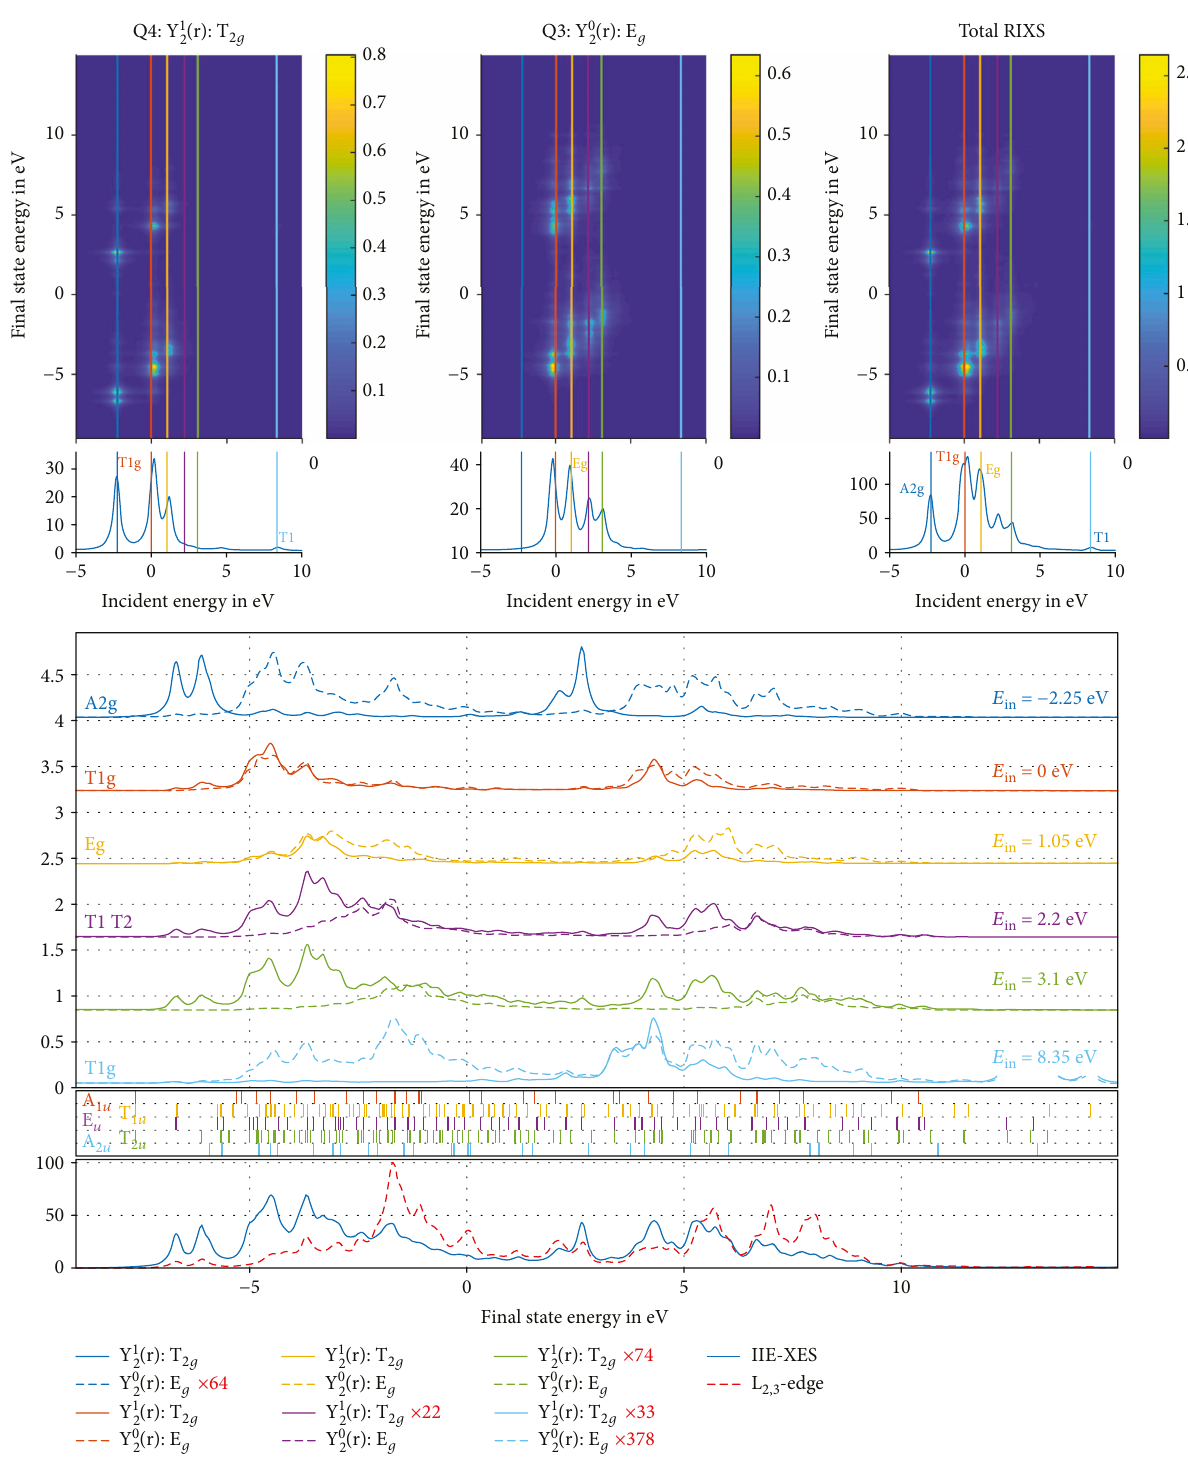
Figure 26: Calculated 1s2p RIXS spectrum for Cr 4+ ( 3d 2 ) for 10D q = 2 1eV . Note that the A intermediate state symmetry is in agreement 2 g with the selection rules only populated via the T 1s XAS IRREP. The slices have been scaled to a comparable intensity to enhance their 2 g character better. The bottom plot compares the integrated incident energy (IIE) 2p XES with the 2p XAS (L 2,3